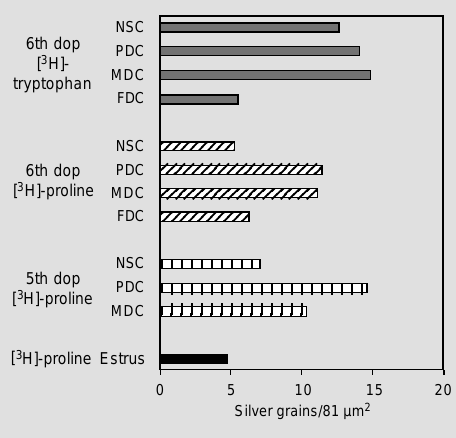
Figure 1 - Incorporation of [ 3 H]- proline or [ 3 H]-tryptophan by mouse endometrial stromal cells during estrus and on the 5th and 6th days of pregnancy (dop). The bars represent the average of sil- ver grain counts per 81 µm 2